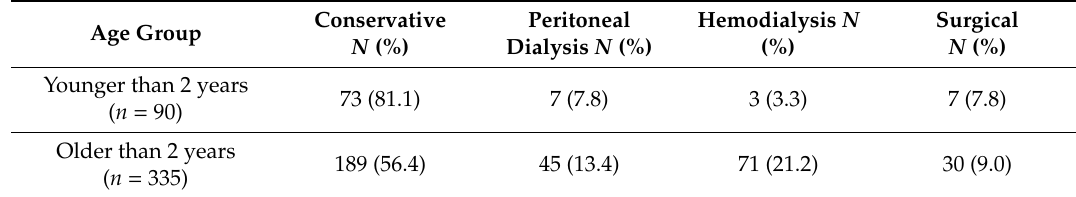
Table 5. Frequency of each management in each age